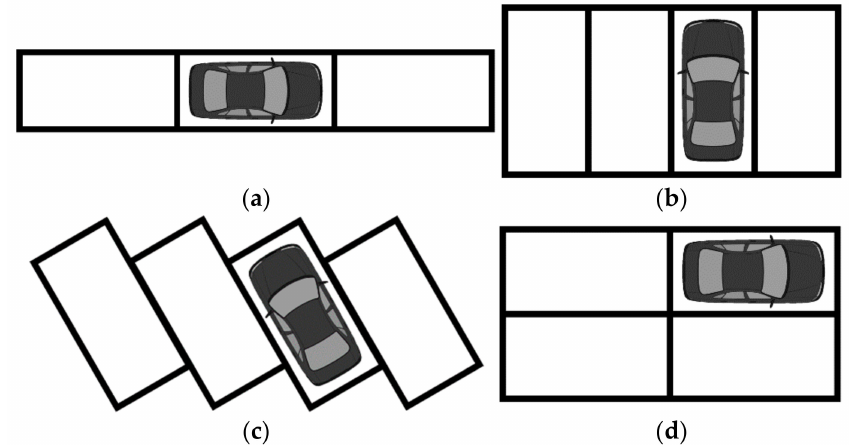
Figure 9. Types of parking slots encountered in the city of Basel. ( a ) (Slotted) parallel parking; ( b ) perpendicular parking; ( c ) angle parking; ( d ) 2 × 2 parking slot